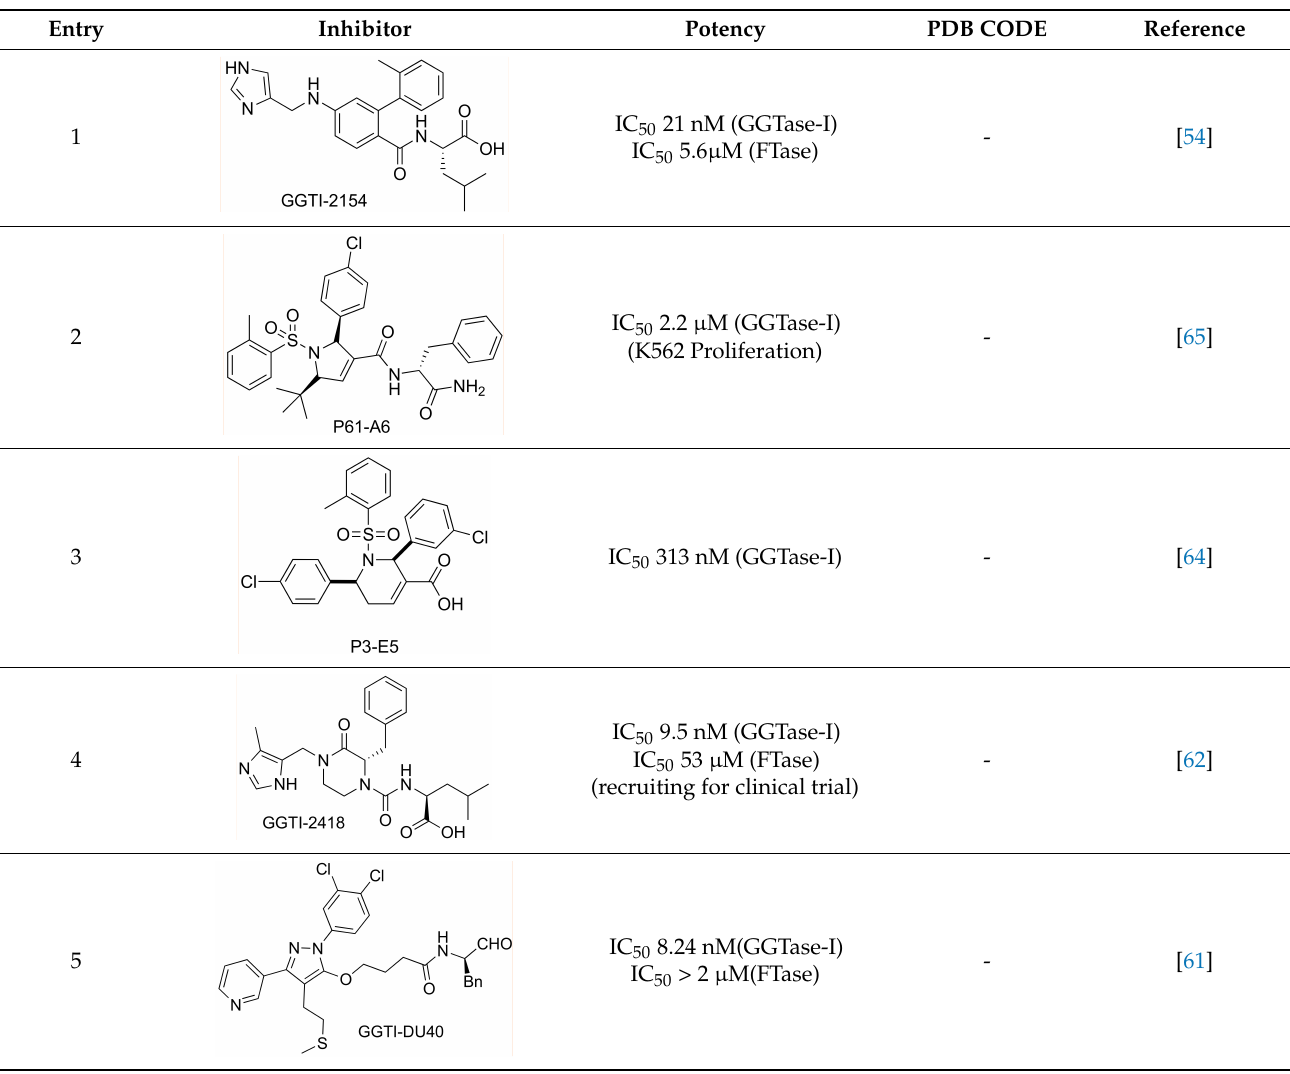
Table 3. Selected inhibitors of